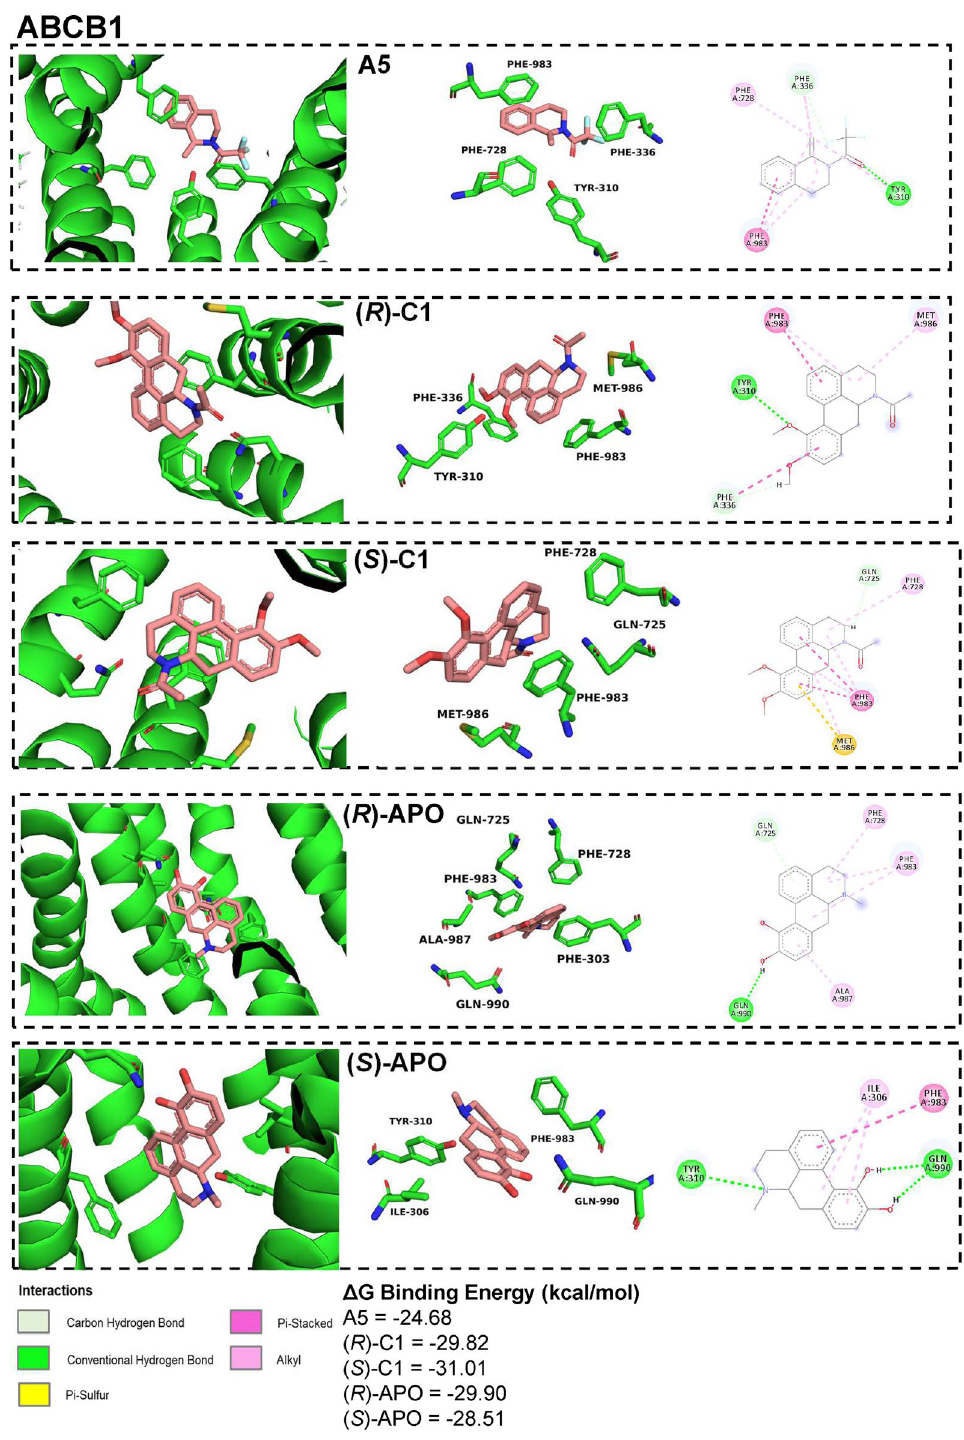
Figure 6. Docking simulations of ABCB1. Docking pose results in 3D and 2D representations of possible interactions of ABCB1 with A5, ( R )-C1, ( S )-C1, ( R )-APO and ( S )-APO. Images were created using Discovery Studio and the interactions with the different amino acids (A: position) are represented in different colors: gray (C-H bonds), green (H-bonds), lilac (Pi-Pi bonds), light purple (alkyl bonds) and yellow (pi-sulfur